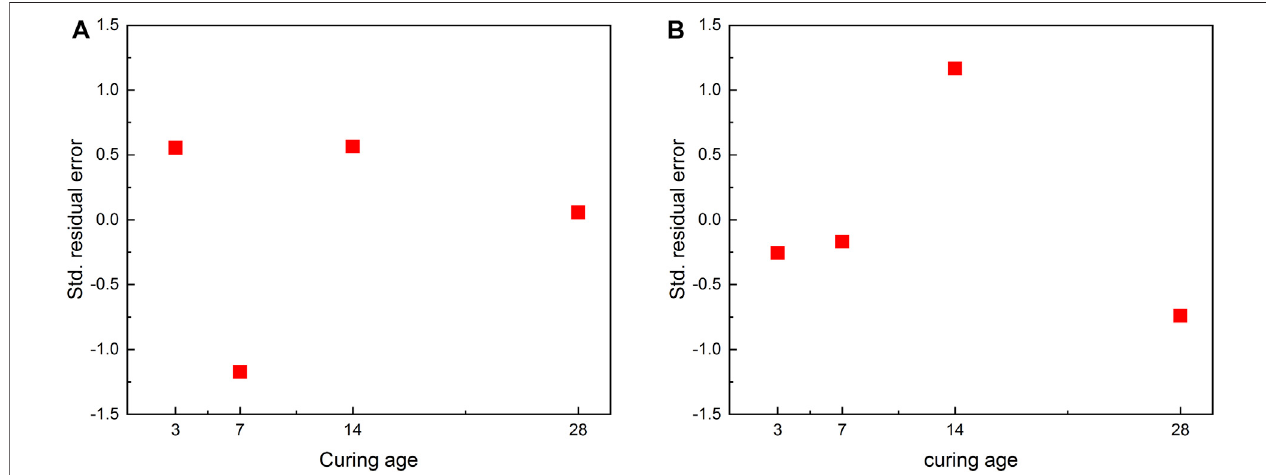
FIGURE 7 | Standardized residual error of regression equation: (A) C/T ratio 1:6; (B) C/T ratio 1:4.